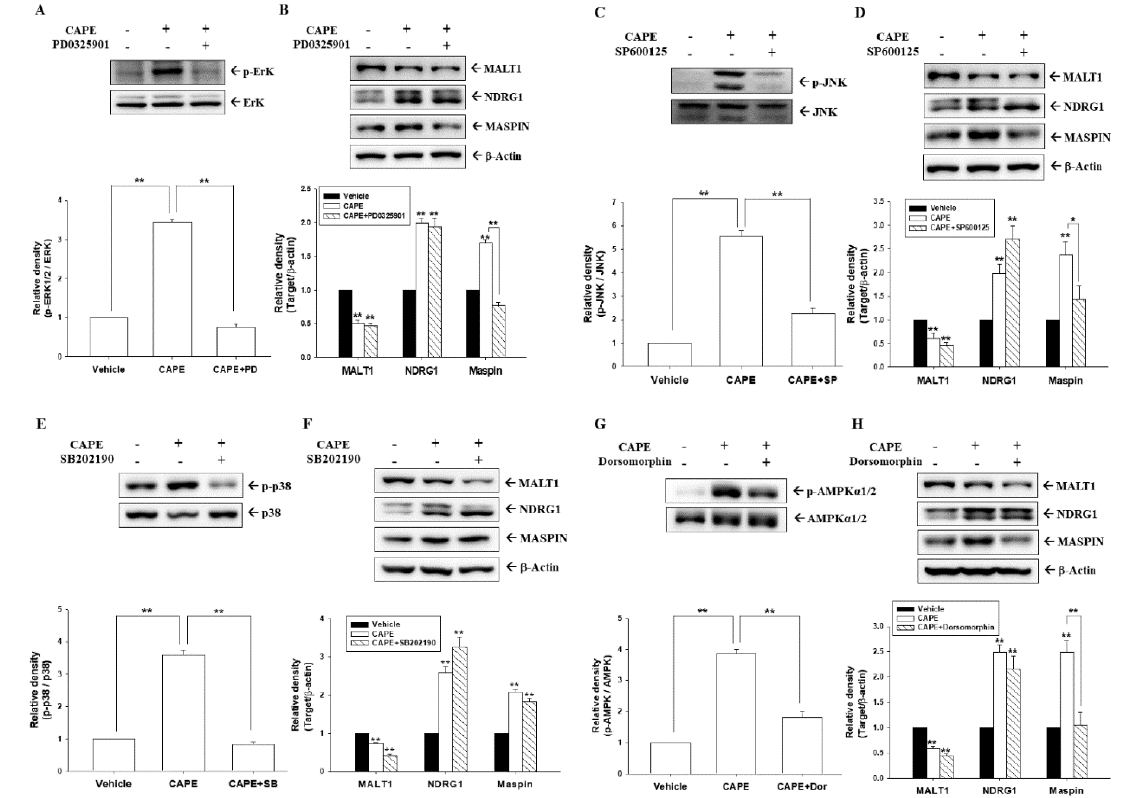
Figure 6. Inhibitors of MAPK and AMPK α 1/2 modulate the expression of MALT1, NDRG1, and maspin in prostate carcinoma cells. The expressions of ERK and p − ERK ( A ), JNK and p − JNK ( C ), p38 and p − p38 ( E ), and AMPK α 1/2 and p − AMPK α 1/2 ( G ) were determined using immunoblot assays after 20 min of 30 µ M CAPE treatments with (+) or without ( − ) pretreatment with the indicated concentrations of inhibitors for 1 h in PC-3 cells. The quantitative data are expressed as the intensity of protein bands of the phosphorylation proteins/total protein levels relative to the control solvent- treated group. The protein levels of MALT1, NDRG1, maspin, and β -actin in PC-3 cells after CAPE treatment with (+) or without ( − ) pretreatment with PD0325901 ( B ), SP600125 ( D ), SB202190 ( F ), or dorsomorphin ( H ). The quantitative data are expressed as the intensity bands of the phosphorylation proteins relative to the total protein levels or intensity of protein bands from the target genes/ β -actin relative to the control solvent-treated group. * p < 0.05, ** p <